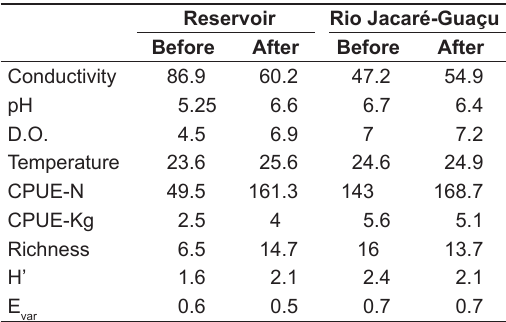
Table 1. Average values of conductivity (µS.cm -1 ), pH, dissolved oxygen (D.O., mg.L -1 ), temperature (°C), Catch Per Unit Effort in number of specimens (CPUE-N) and in biomass (CPUE-kg), species richness, diversity (H’) and evenness (E ) indices, in the Rio Jacaré-Guaçu and var in the Gavião Peixoto Reservoir before and after the dredging and management of